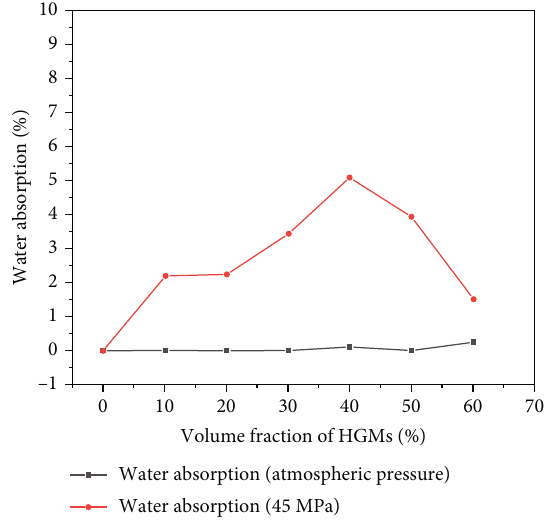
Figure 9: Water absorption curves of the HGM/EP composite insulation